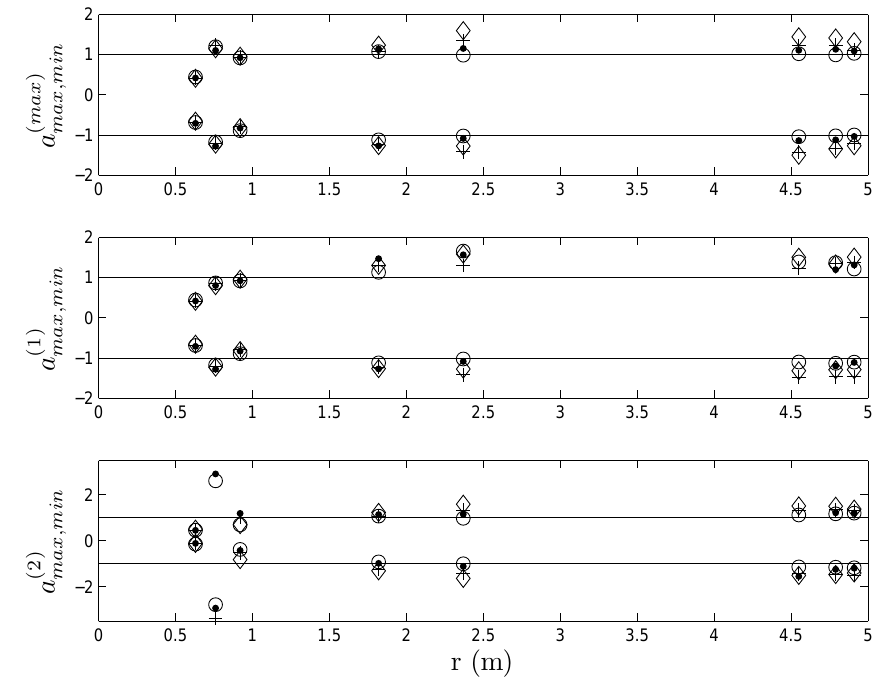
Fig. 7. Positive and negative maximum free water surface elevations obtained from the proposed numerical model for the four landslide kinematics. The different markers refer to the different initial position of the landslide above the undisturbed shoreline: ζ = 0 . 30 m (circle), ζ = 0 . 40 m (point), ζ = 0 . 50 m (plus sign) and ζ = 0 . 60 m (diamond). All these values are normalized with the appropriate experimental measurements.